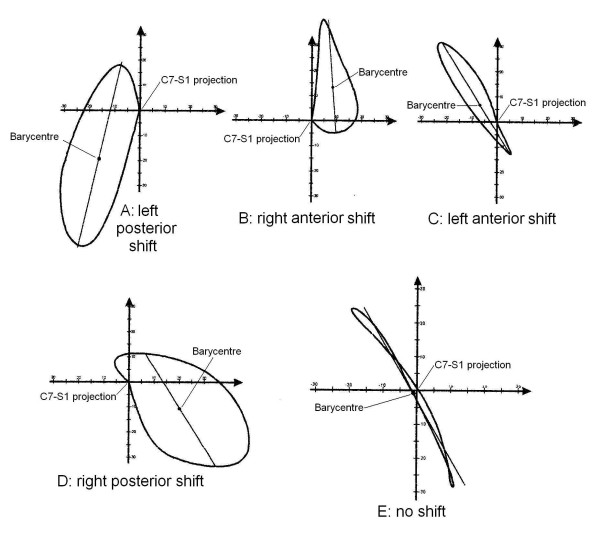
Examples of different Shifts. The Shift classificatory parameter is the displacement of the barycentre of the Top View with respect to the spinal normal axis; it was defined as Shift because it is as if the pathological spine had changed its position with respect to the pelvis, "shifting" away from the vertical C7-S1 axis. A: Left Posterior Shift; B: Right Anterior Shift; C: Left Anterior Shift; D: Left Posterior Shift; E: no shift. For clinical and 3 DEMO complete data of these patients see Appendix [see Additional file 1].